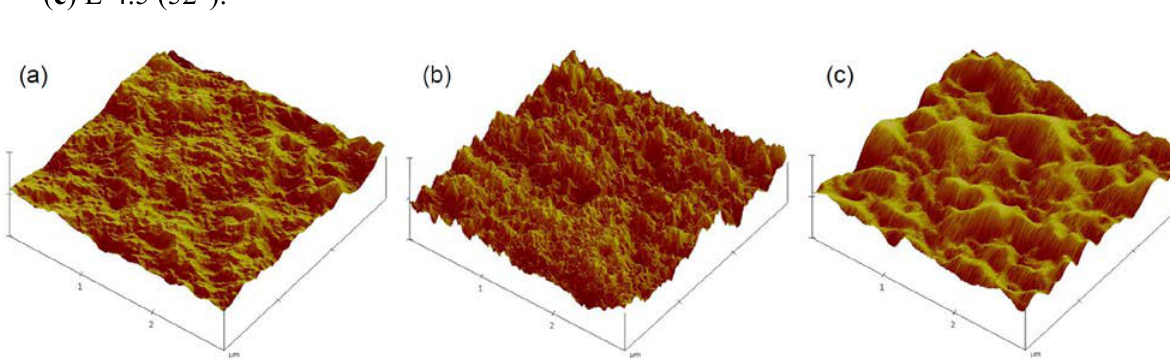
Figure 2. Atomic force microscopy (AFM) images of ( a ) L-0.5 (93°); ( b ) L-2.5 (65°) and ( c ) L-4.5 (52°).